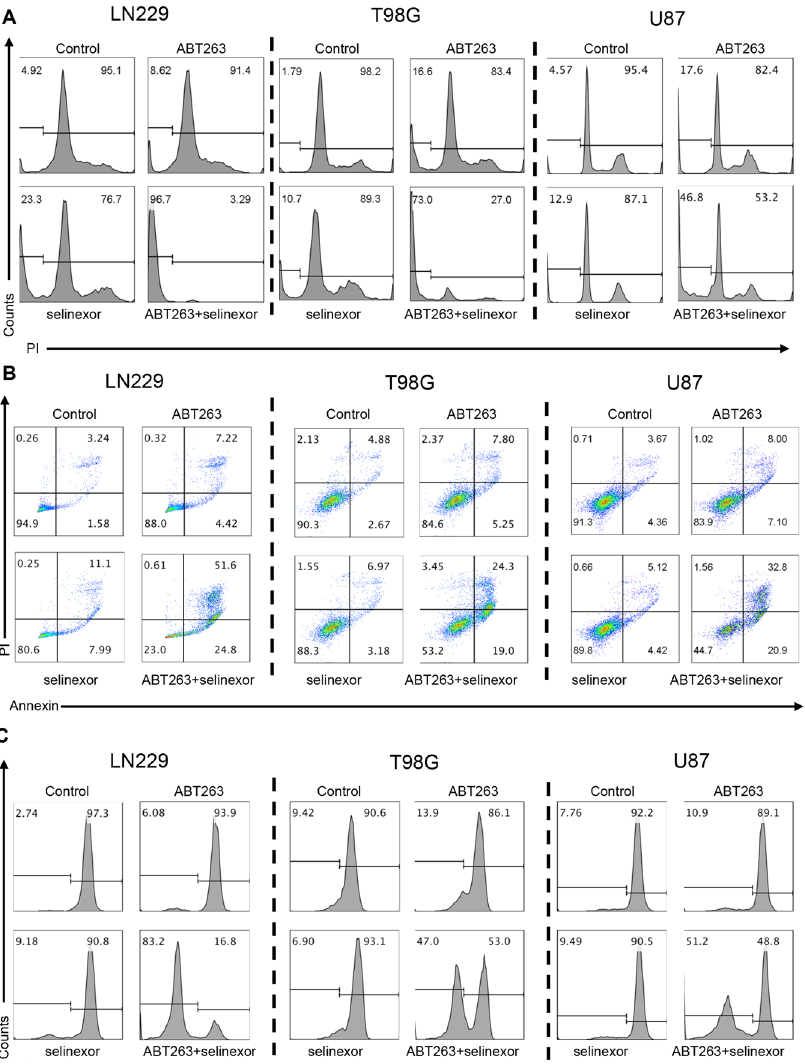
Figure 2. The combination treatment of ABT263 and selinexor shows features of apoptotic cell death. ( A ) LN229, T98G and U87 GBM cells were treated with ABT263, selinexor or the combination. After 72 h, cells were harvested, fixed, stained with propidium iodide and analyzed by flow cytometric analysis for DNA – fragmentation. Shown are representative flow cytometry plots. ( B ) The same set of cell lines as in A were treated with the indicated drugs and the same conditions (except for the incubation time, which was 24 h). Thereafter, cells were stained with Annexin V/Propidium iodide and analyzed by multi-parametric flow cytometry. Shown are representative plots. ( C ) The same set of cell lines as in A were treated with the indicated drugs and the same conditions (except for the incubation time, which was 24 h). Thereafter, cells were stained with TMRE and analyzed by flow cytometry. Shown are representative flow